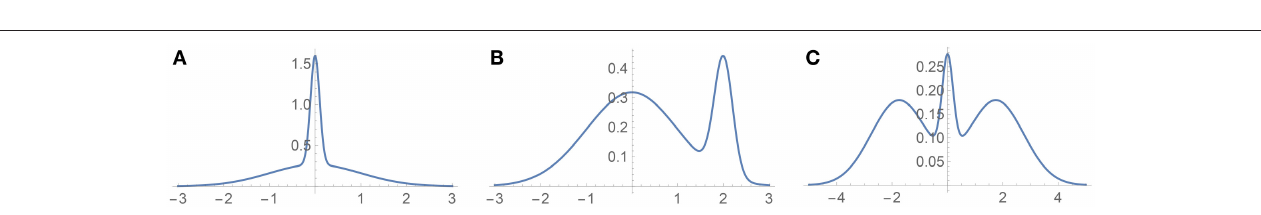
FIGURE 4 | Test densities (Gaussian mixtures) used in our univariate simulation study. (A) H3 (Kurtotic unimodal); (B) H4 (Skewed bimodal); (C) H5